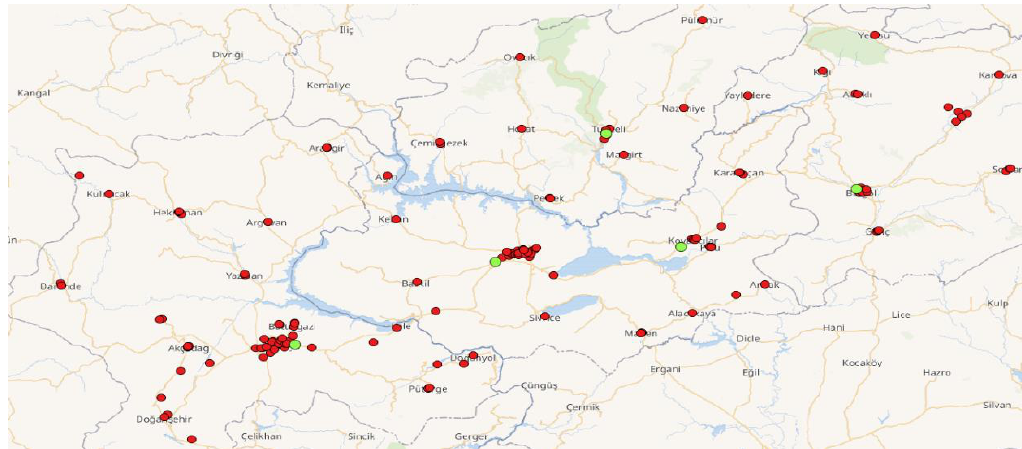
Figure 2 . The locations of 167 collection centers (red nodes) and 5 disposal centers (green nodes)